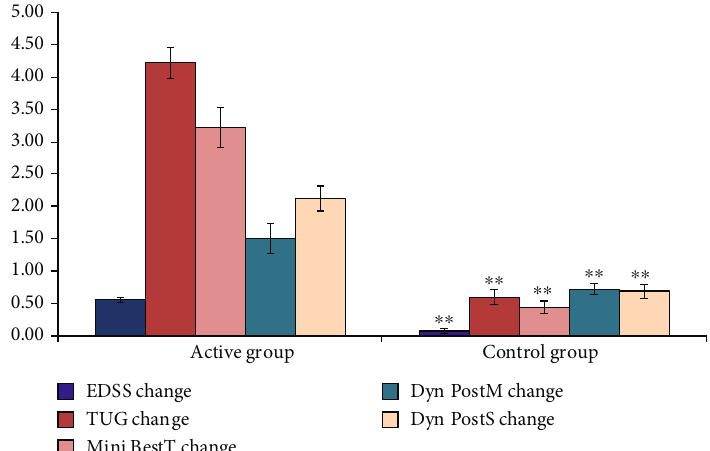
Figure 1: Comparison between active and control as regards to all studied variables. SD: standard deviation; ∗ P < 0 : 05 between group comparison; ∗∗ P < 0 : 01 .